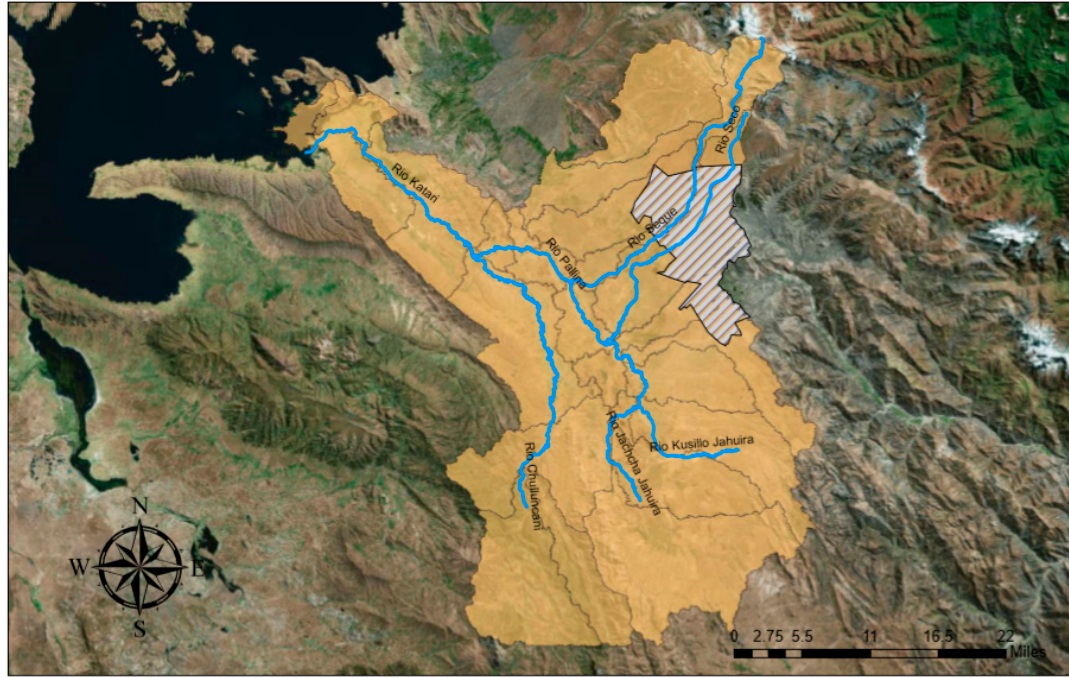
Figure 1. Katari River Basin.